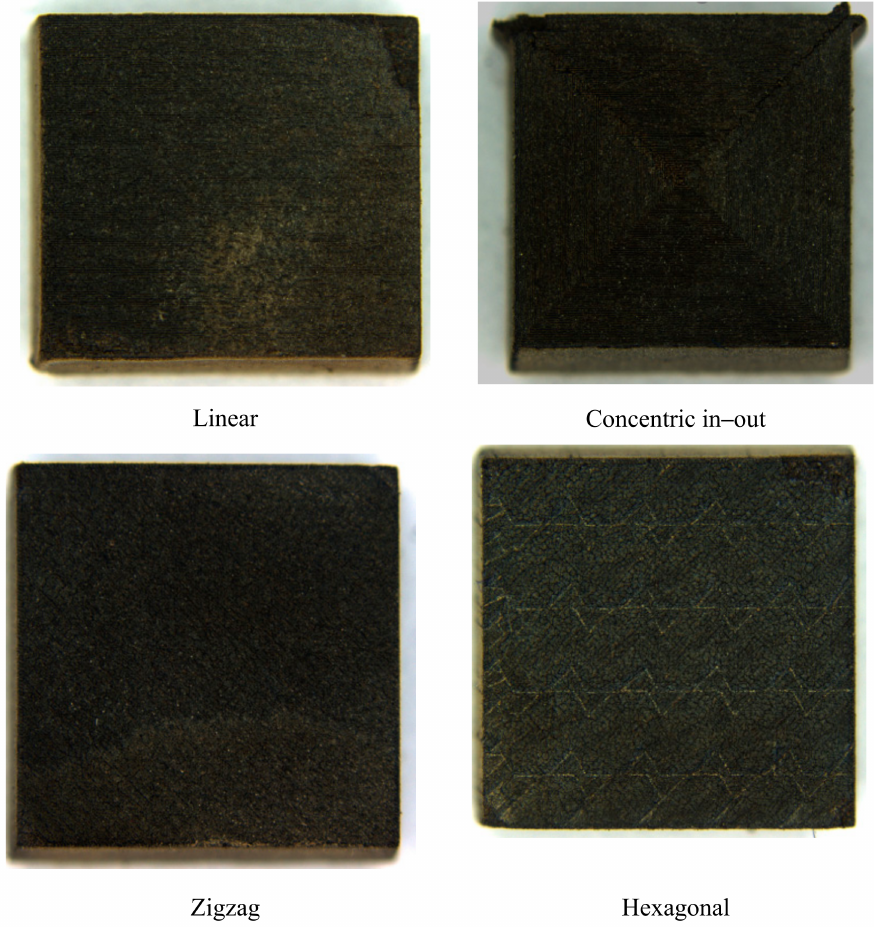
Figure 12. Three-dimensional microscope images for SiC sample top surfaces printed using different scanning